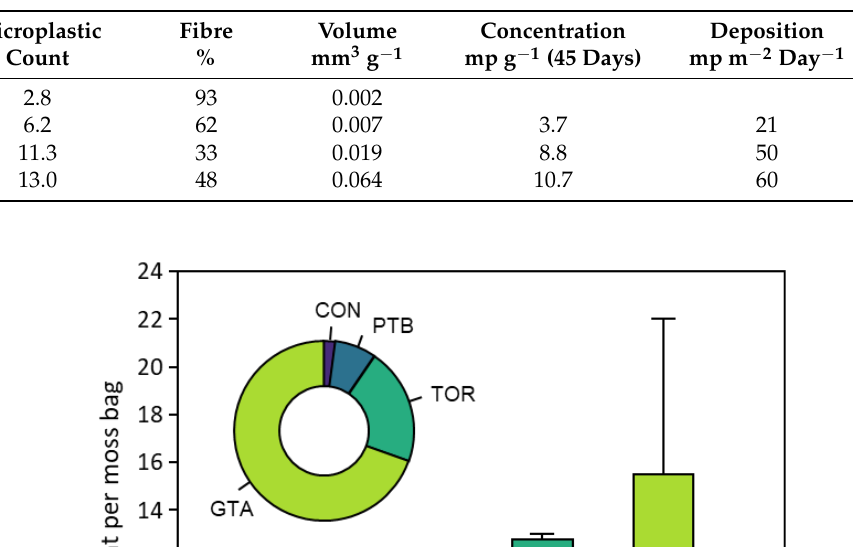
Table 3. Mean microplastic count, percent fibre, mean microplastic volume in the unexposed control (CON) bags and three urban intensity groups (PTB, TOR, and GTA), and accumulated concentration (mp g − 1 ) in moss bags (dry weight) during the deployment period (45 days; 9 October–23 November 2020). Estimated daily deposition of microplastics (mp) and plastic microfibres (mf) are also shown.